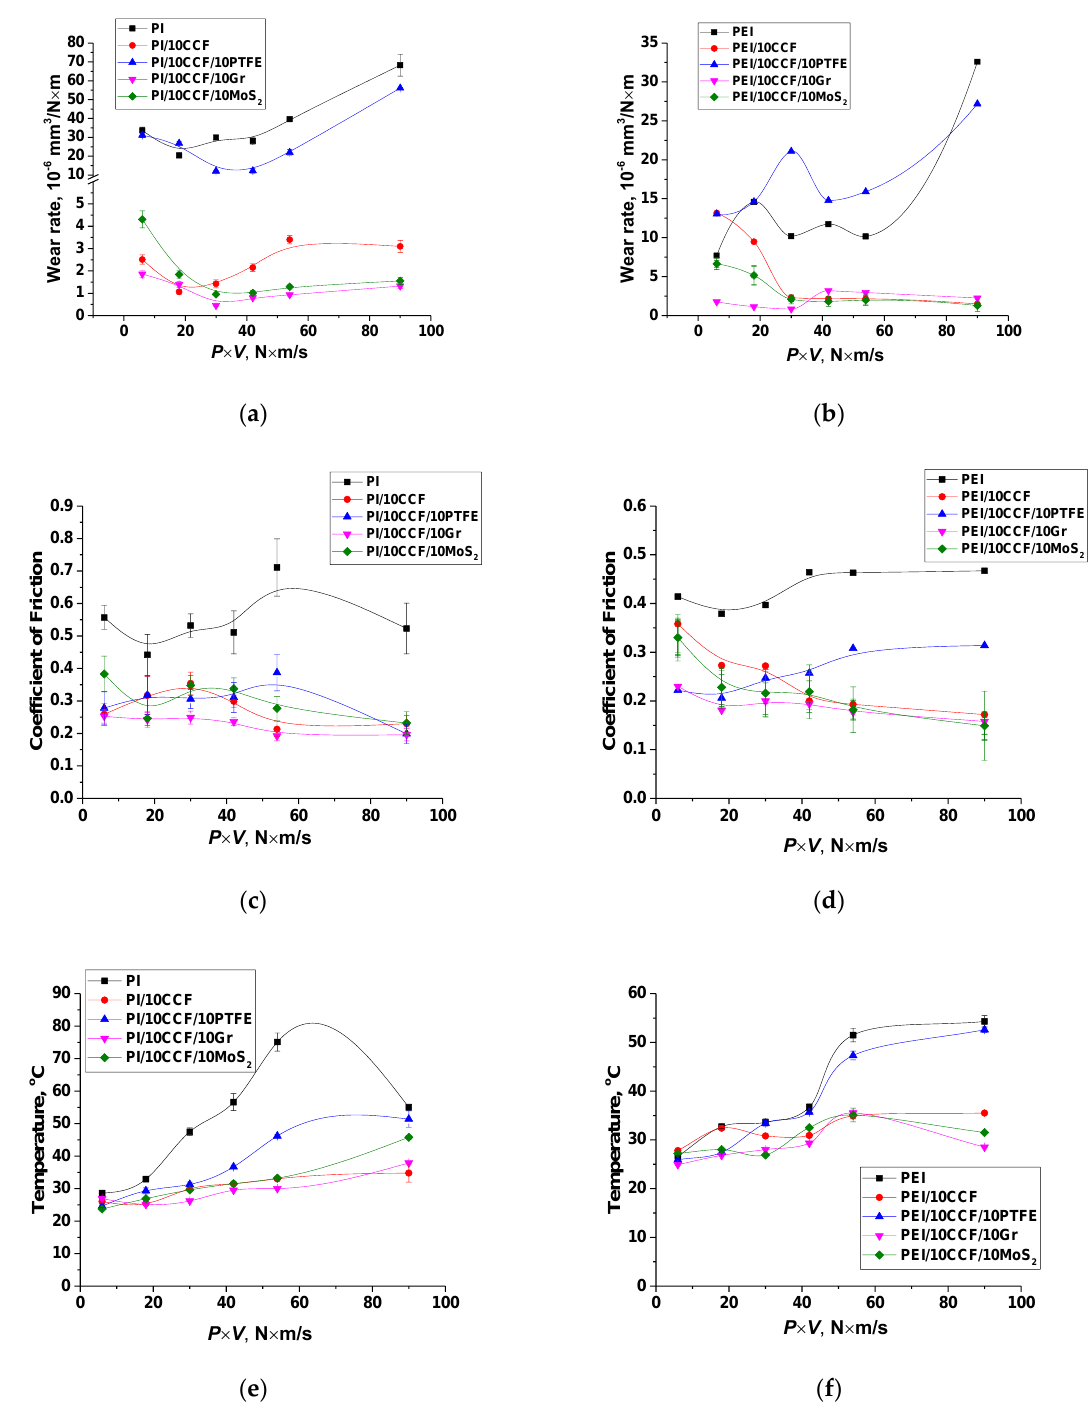
Figure 4. Dependences of the WR values ( a , b ), the CoF levels ( c , d ) and the surface temperatures ( e , f ) from the P · V load-speed parameter for the PI- ( a , c , e ) and PEI-based ( b , d , f ) materials. The metal-polymer tribological contact (the ‘block -on- ring’ scheme).